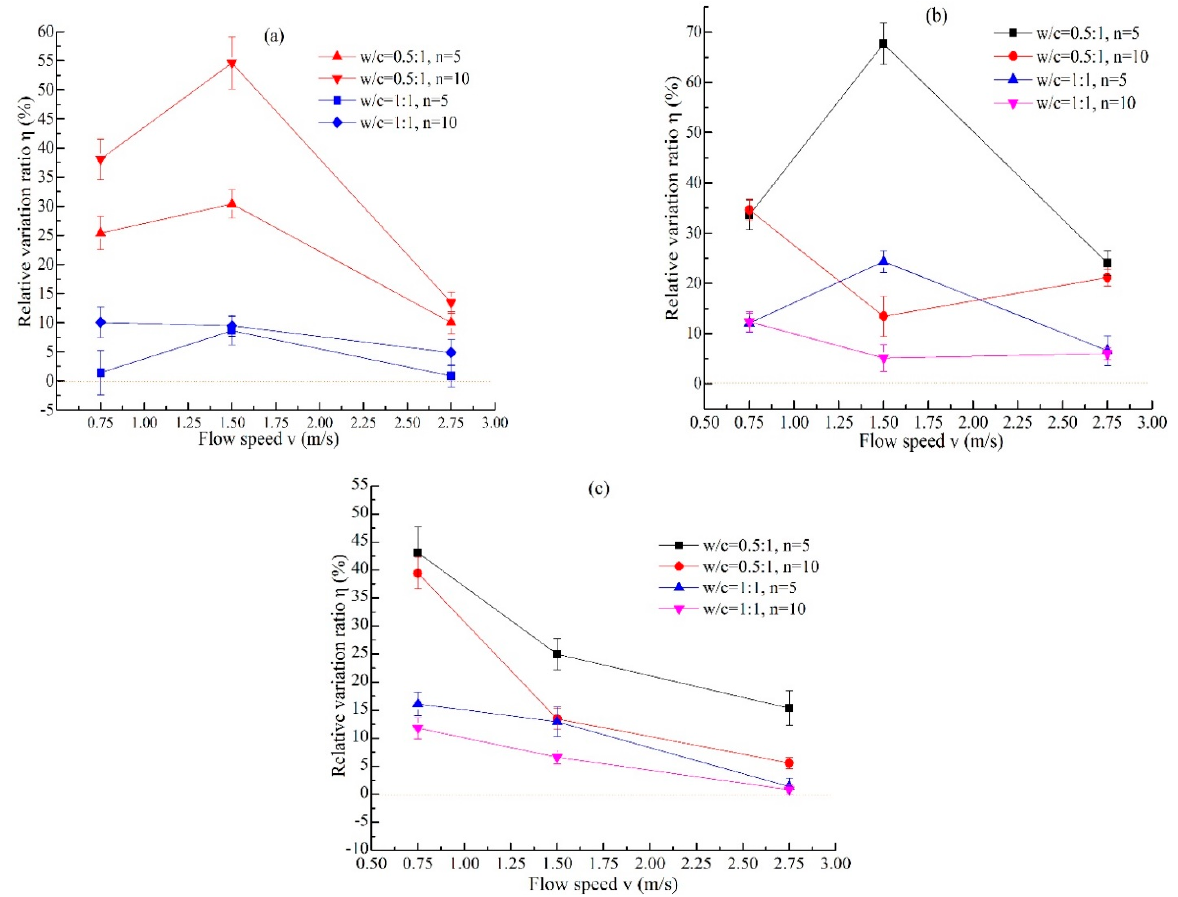
Figure 11. The values of η change with water flow speed under different magnetization conditions (( a ) B = 136 mT, ( b ) B = 236 mT, ( c ) B = 656 mT).